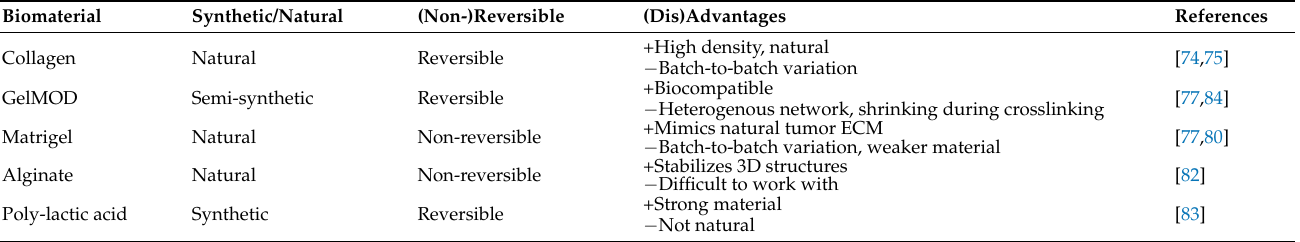
Table 2. The categorization, advantages (+), and disadvantages ( − ) of the most used biomaterials in